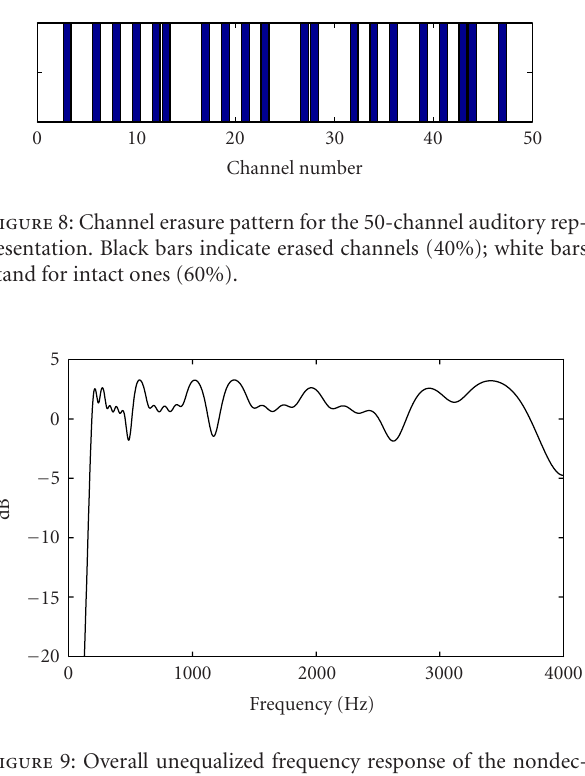
Figure 9) if no equalizer is used. The factor ( B − A ) / ( B + A ), which bounds distortion, is − 3 .